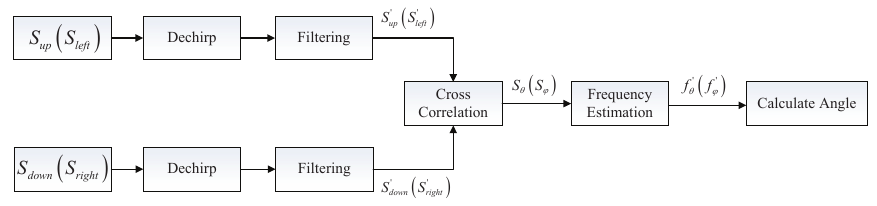
Figure 5. The structure of the proposed monopulse angle